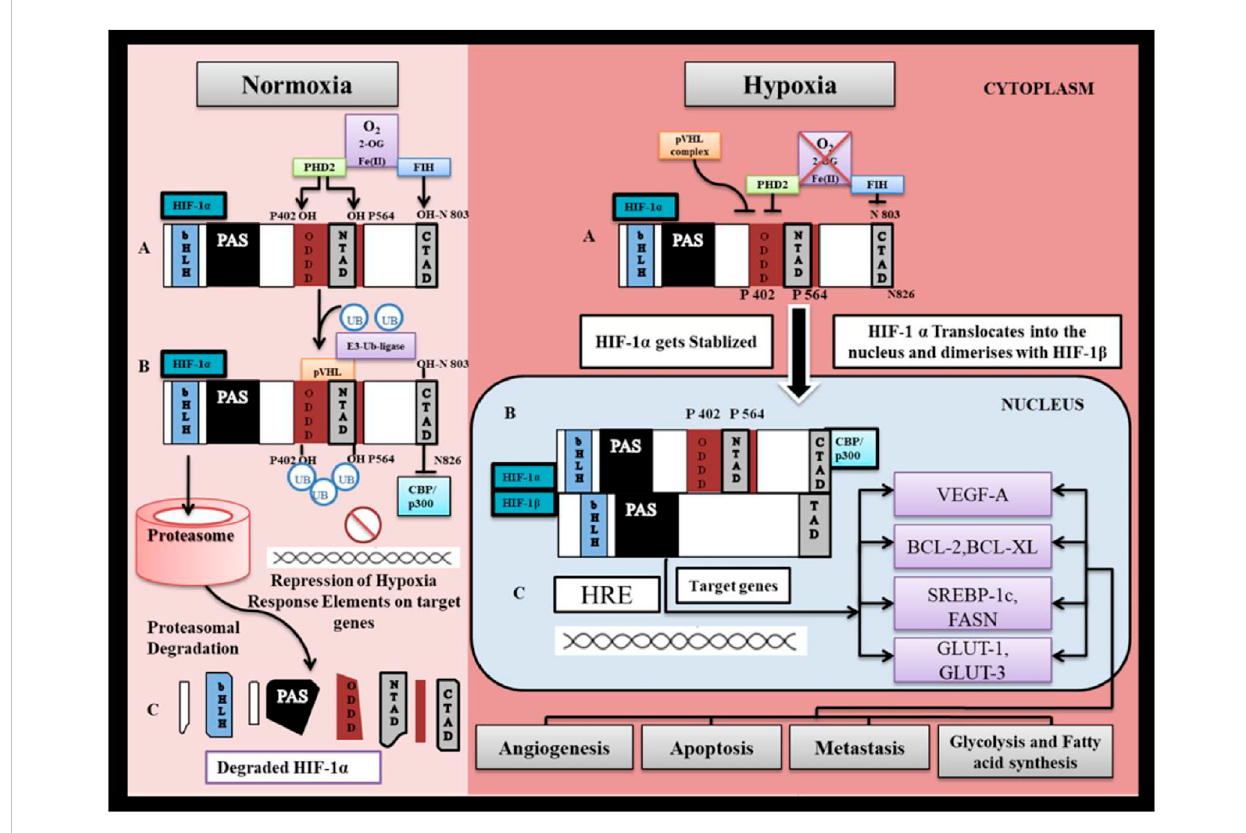
FIGURE 3 HIF-1 α regulation under normoxia and hypoxia. I. Normoxia represents pO 2 > 40 mm Hg. (A) Under normal oxygen tension, PHD2 (prolylhydroxylase-2) hydroxylates HIF-1 α at proline residues P402 and P564 and Factor Inhibiting HIF-1 α hydroxylates HIF-1 α at asparagine residue N803. in presence of O2 as substrate, Oxoglutarate as co-substrate and Fe as cofactor. (B) Prolyl Hydroxylation of HIF-1 α allows for binding of pVHL to NTAD (N-terminal transactivation domain) of HIF-1 α . Binding of pVHL recruits ubiquitinin byactivation of E3- ubiquitinin ligase whichmarks HIF-1 α for proteasomal degradation. (C) HIF-1 α is degraded by 26S proteasome thus preventing stabilization and accumulation of HIF-1 α . Asparginyl hydroxylation of HIF-1 α at CTAD (C-terminal transactivation domain) prevents binding of CBP/P300 to the CTAD (CH- 1 domain) and thereby inhibiting downstream mechanism involved in HIF-1 α transactivation. II. Hypoxia represents pO 2 < 40 mmHg. (A) Under hypoxia HIF-1 α escapes degradation and gets stabilized since PHD2 enzymes which are responsible for its proteasomal degradation are inhibited. (B) Stabilized HIF-1 α gets accumulated in the cytosol till the oxygen tension reaches the level (pO 2 > 10 mmHg) that it becomes limiting for FIH-1, such that CBP/P300 proteins are able to bind to CTAD. (C) HIF-1 α translocate into the nucleus to bind with β -subunit that is constitutively expressed in the nucleus. HIF-1 α further binds with hypoxia response element on targeted gene and trigger gene